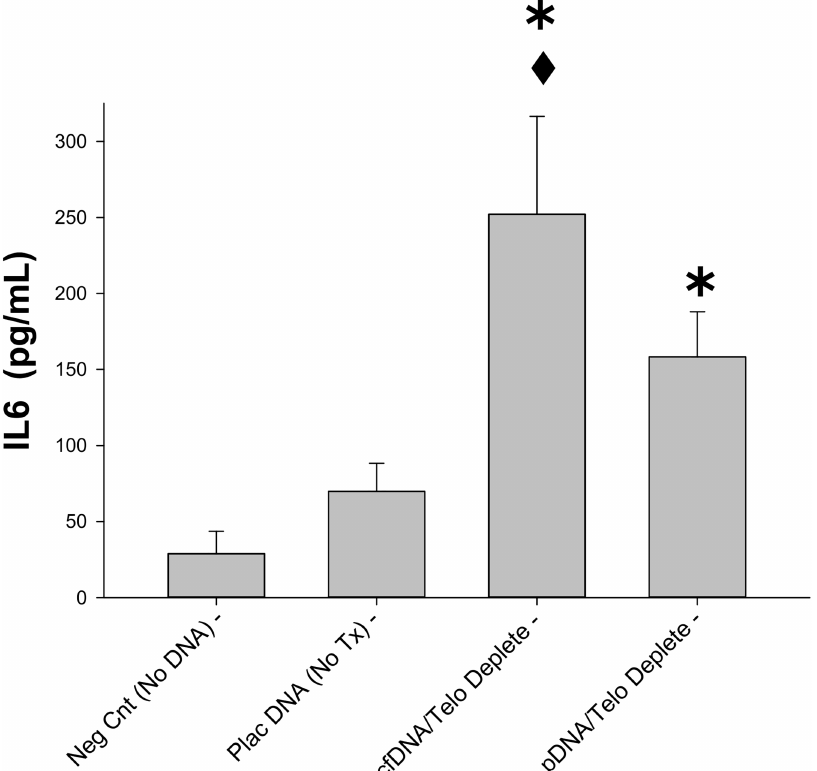
Fig 5. Stimulation of macrophage IL6 secretion. Bar graph demonstrating IL6 secretion (pg/mL culture media)by cultured RAW macrophage cells in response to stimulationby untreatedplacentalDNA (Plac DNA (No Tx)), placentalexplant cell-free DNA depleted of telomere regions(cfDNA/Telo deplete), and placental tissue DNA depletedof telomere regions (pDNA/Telo deplete),. Negativecontrol (Neg Cnt (No DNA)) = IL6 in media of unstimulated RAW cells. Data reported in mean ± S.D., N = 4–9, * = p < 0.05 comparedto untreated placentalDNA and ◆ = p < 0.001 for cfDNA/Telo depletecomparedto pDNA/Telo deplete.